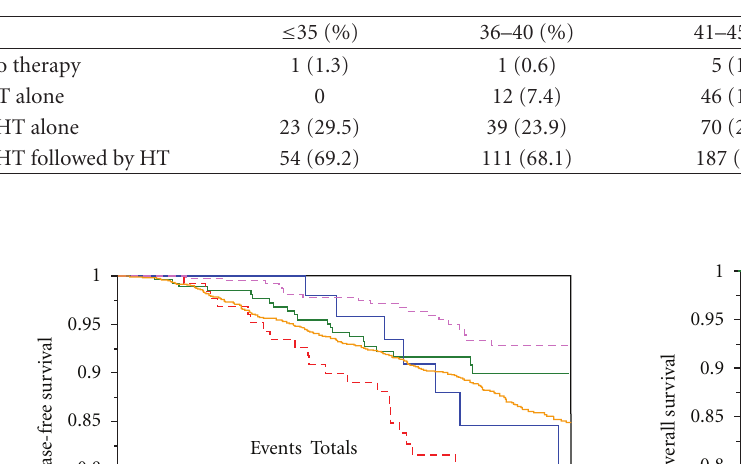
Table 7: Type of adjuvant therapy in the young population and in the subgroups stratified by age.